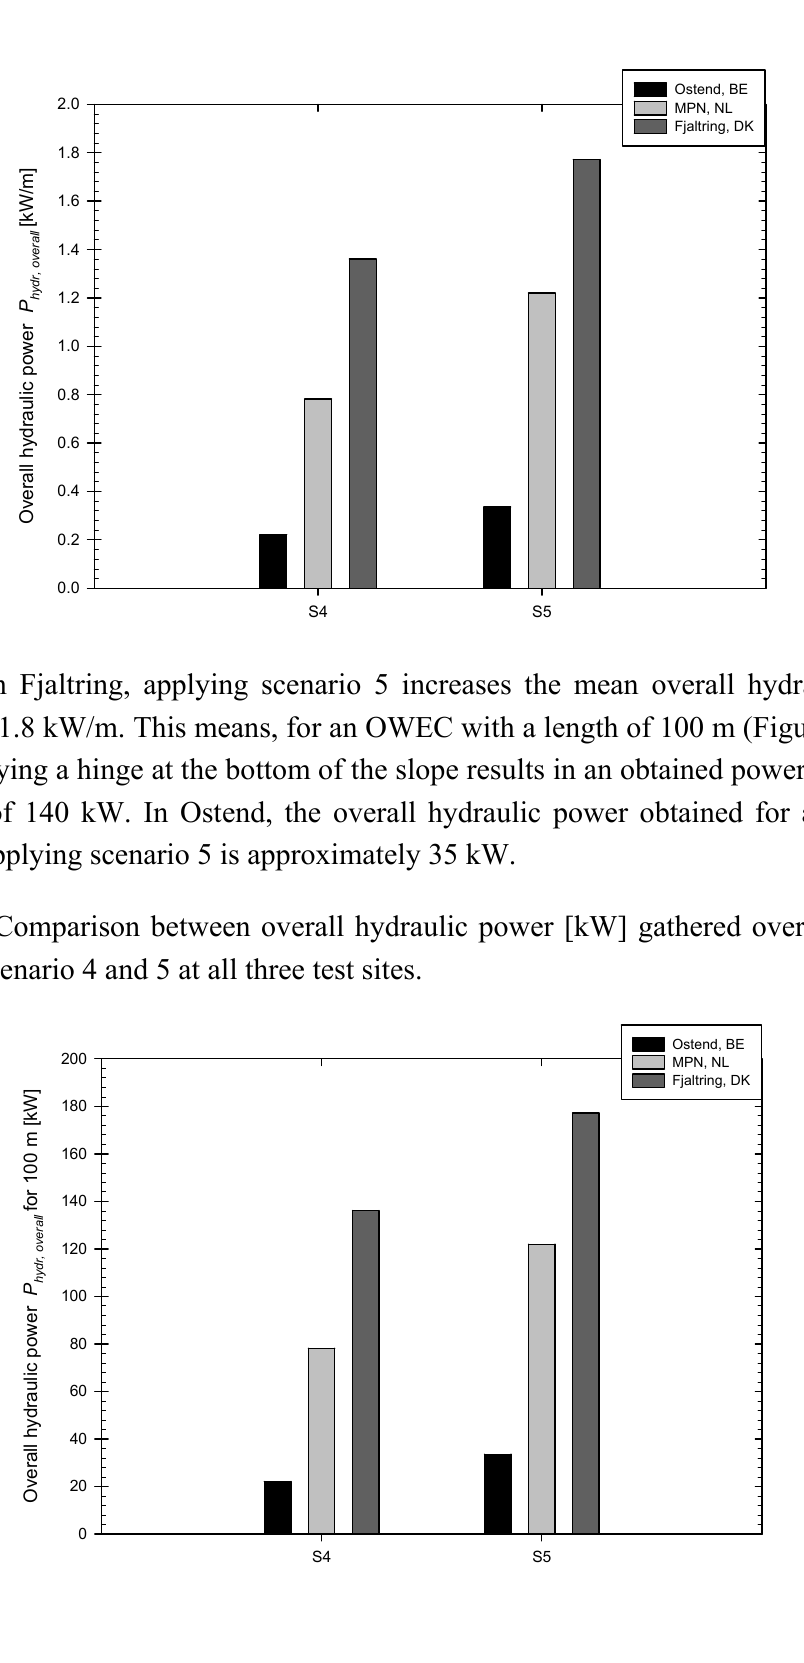
Figure 11. Comparison between overall hydraulic power for scenario 4 and 5 at all three test sites.